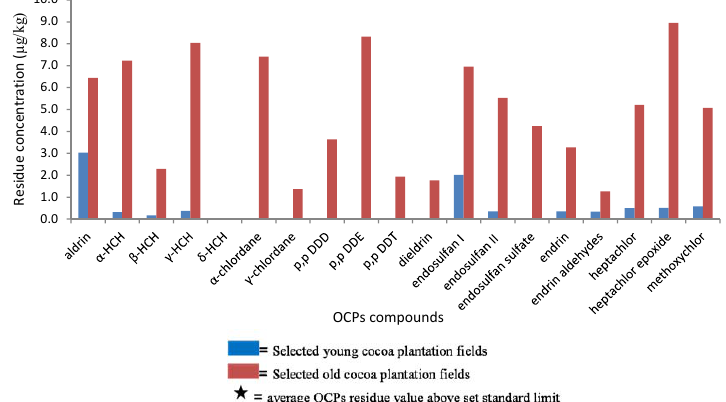
Fig. 2d : Organochlorine pesticides residue profile level in cocoa plantation soil of Osun.